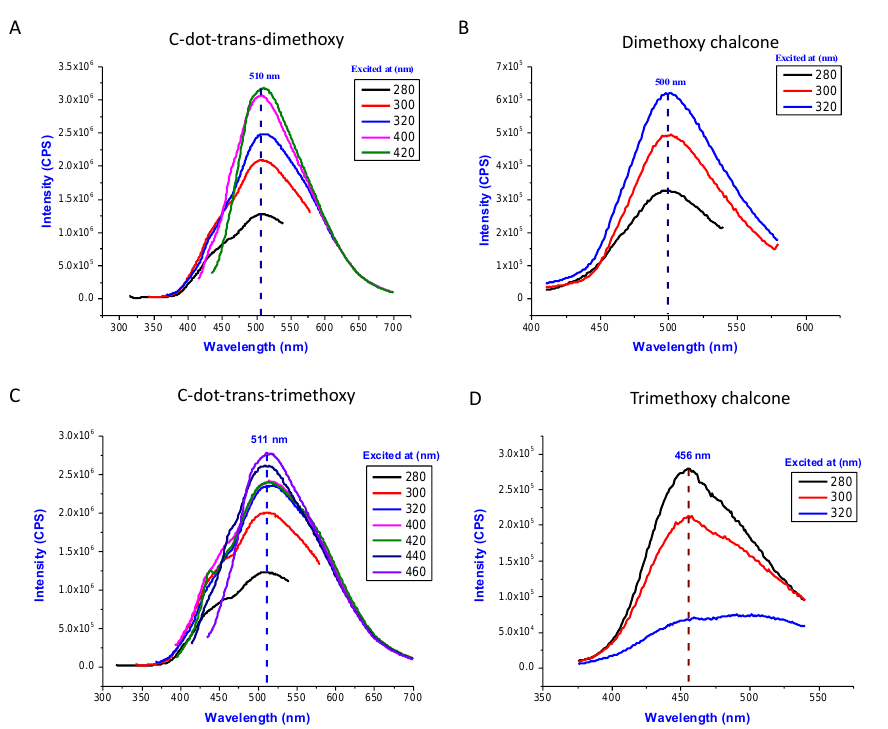
Figure 7. Fluorescence emission spectra. ( A ) Fluorescence emission spectra of the C-dots-trans-dimethoxy chalcone conjugate. ( B ) Fluorescence emission spectra of 4′ amino-3,5-trimethoxy chalcone. ( C ) Fluorescence emission spectra of the C-dots-trans-trimethoxy chalcone conjugate. ( D ) Fluores- cence emission spectra of 4′ -amino-3,5- trimethoxy chalcone Samples (10 μg /mL) were tested in a 5 nm slit width for both excitation and emission.